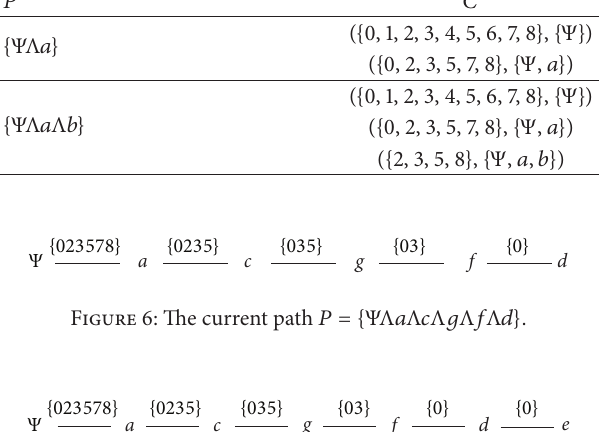
Figure 7: The path updated from the path listed in Figure 6.